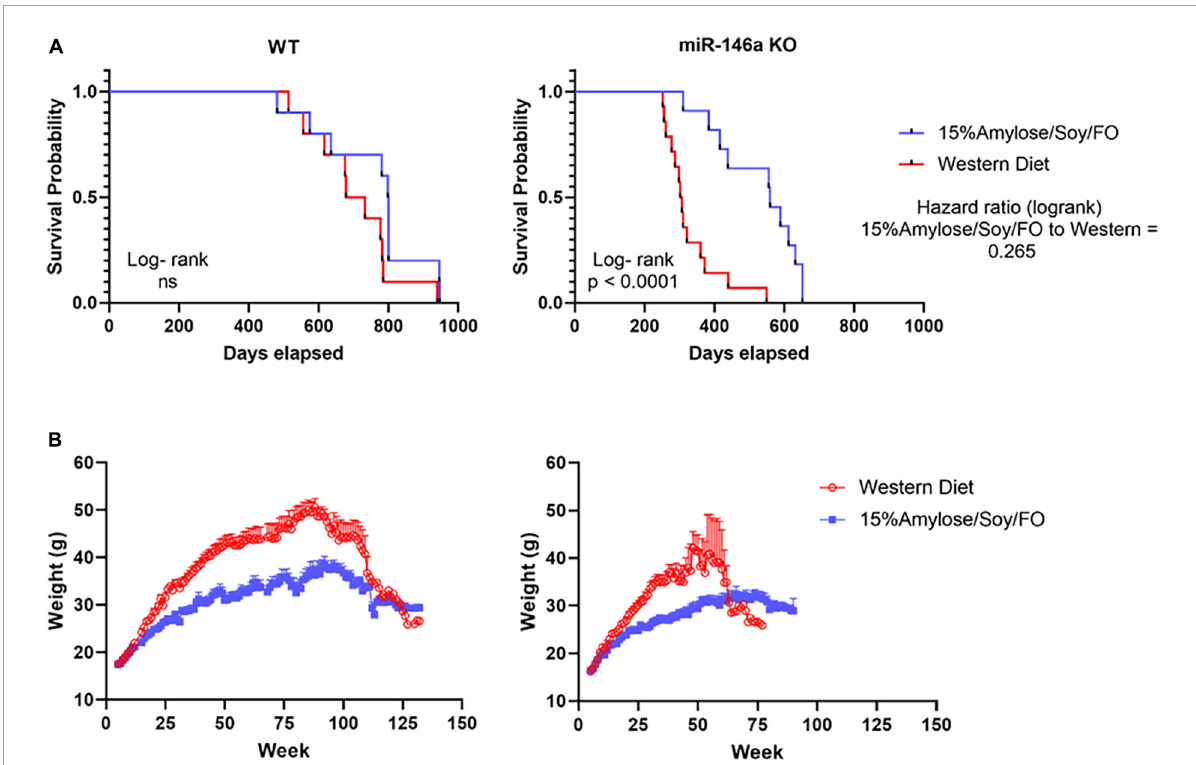
FIGURE1 A 15%Amylose/Soy/FO diet extends the lifespan and reduces the weight of miR-146a KO mice. At 5 weeks of age miR-146a KO (left panel) or WT (right panel) C57Bl/6 mice were housed in two-tiered rat cages with exercise wheels and put on a Western (15 mice) or the 15%Amylose/Soy/FO diet (15 mice) and their (A) survival monitored and (B) their weights monitored weekly.